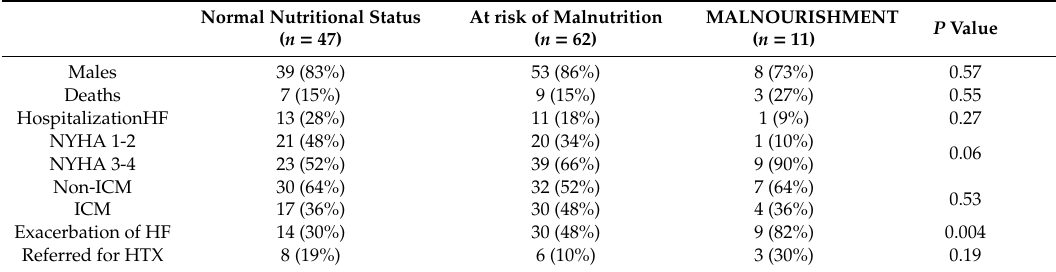
Table 2. Nonparametric characteristics of ‘normal nutritional status’, ‘at risk of malnutrition’, and ‘malnourishment’ subgroups. Normal Nutritional Status ( n =